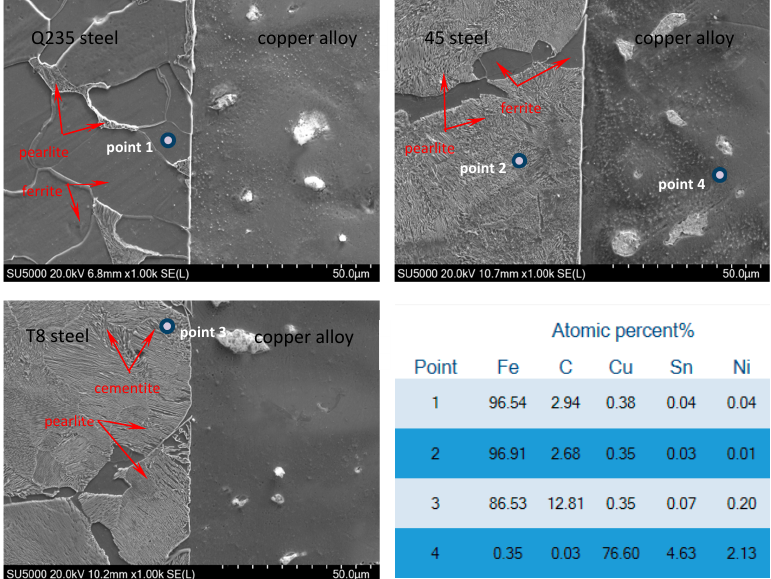
Figure 6. SEM micro-images and EDS point analyses of the interface microstructure of the steel/copper bimetallic castings using rapid induction heating.